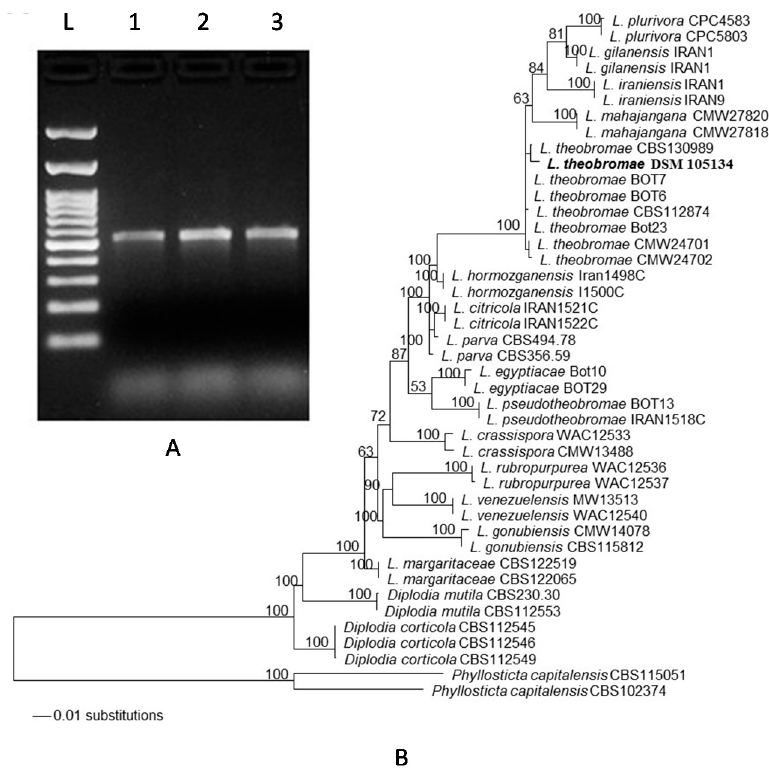
Figure 2. Molecular identification of L. theobromae. ( A ) PCR amplification of the ITS rDNA region in infected leaves, twigs and apical tips (lanes 1–3, respectively); and ( B ) dendrogram showing phylogenetic relationships of the fungal sequence of the specimen used in this study (DSM 105134) with the most related ITS and TEF1- α sequences in GenBank (accession number, MF114110), prepared by the neighbour-joining method. The maximum likelihood tree is obtained from combined ITS / TEF1- α sequence data. Numbers at the nodes are ML bootstrap values after 100 replicates are expressed as percentages (LnL = − 3497.793130). The scale bar on the rooted tree indicates a 0.01 substitution per nucleotide position. The strain from this report is indicated in bold. ITS , internal transcribed spacer; TEF1- α , translational elongation factor 1- α ; L, DNA ladder.